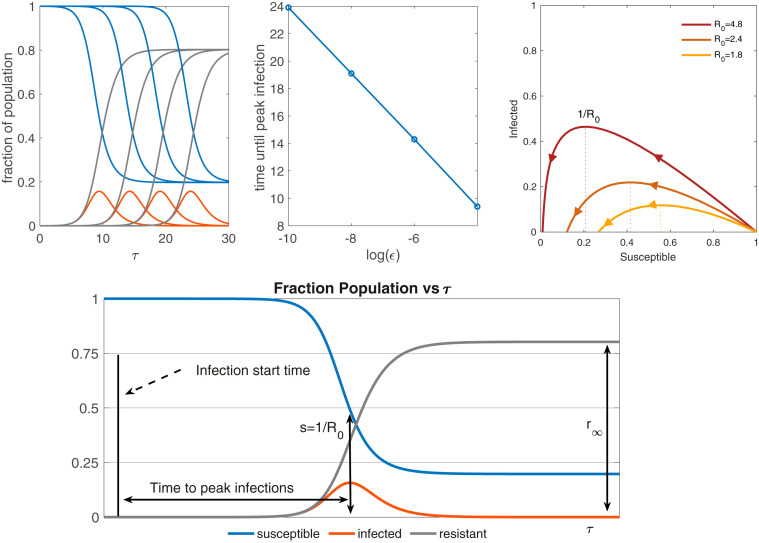
Solution of the dimensionless SIR model (5) with R0=2. Upper Left shows the graphs of s (blue), i (orange), and r (gray) on the vertical axis vs. τ on the horizontal axis, for different ϵ. The corresponding values of ϵ from left to right are 10−4, 10−6, 10−8, 10−10, respectively. Upper Center shows the time until peak infections vs. log(ϵ) for the values shown in Upper Left. This asymptotic tail to the left makes it challenging to fit data to SIR in the early stages. Upper Right is a phase diagram for fraction of infected vs. fraction of susceptible with the direction of increasing τ indicated by arrows, for three different values of R0. Lower displays a typical set of SIR solution curves over the course of an epidemic, with important quantities labeled.